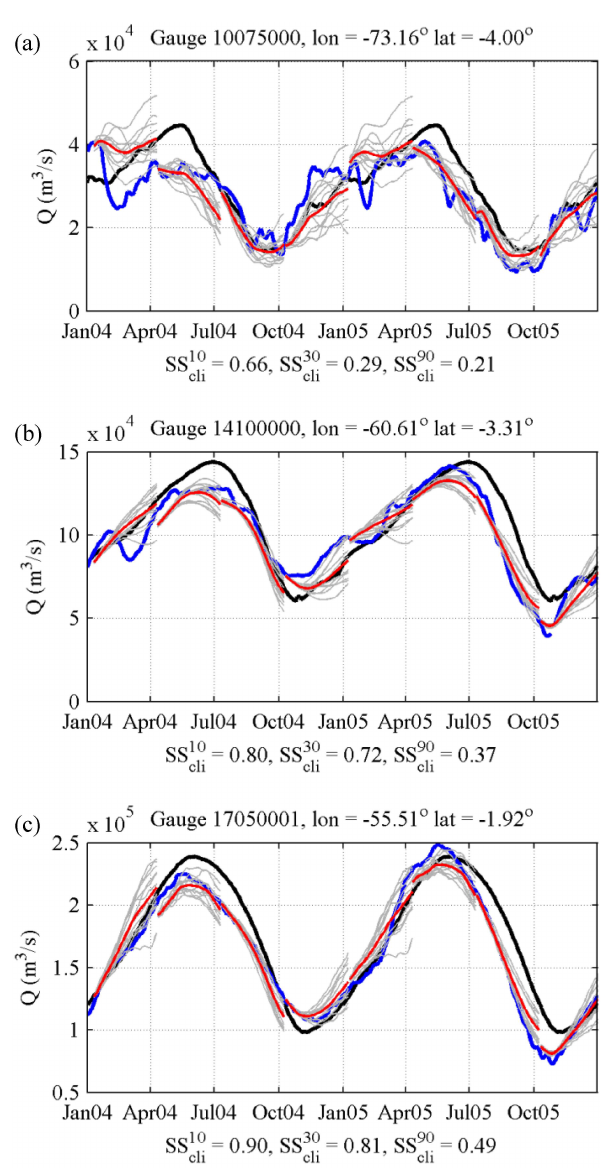
Fig. 8. Evaluation of streamflow forecasts. Observed (blue), cli- matological (black) discharges, ensemble forecasts (grey) together with ensemble mean (red) at (a) Upper Solim˜oes River at Tamishiy- acu, (b) Solim˜oes River at Manacapuru and (c) Amazon river at ´Obidos. Presented forecasts started each 10 January, April, July and October. Sites are indicated in Fig.